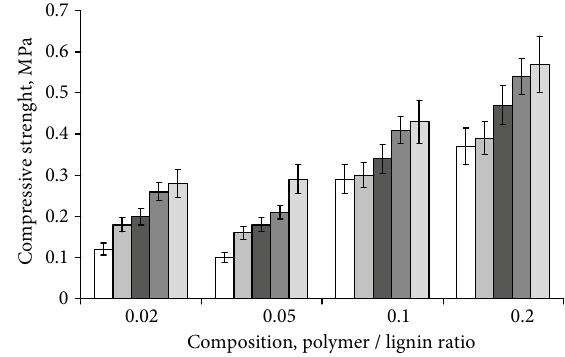
Fig. 3. Compressive strength of composites made from